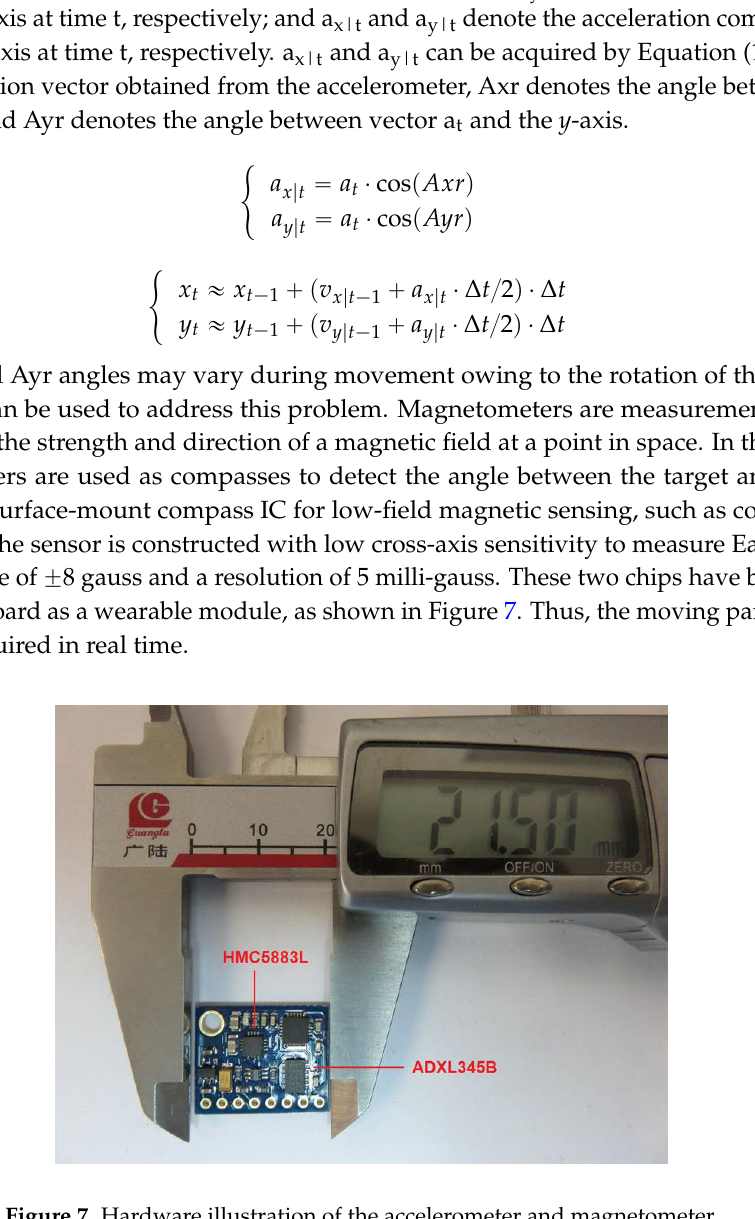
Figure 7. Hardware illustration of the accelerometer and magnetometer.